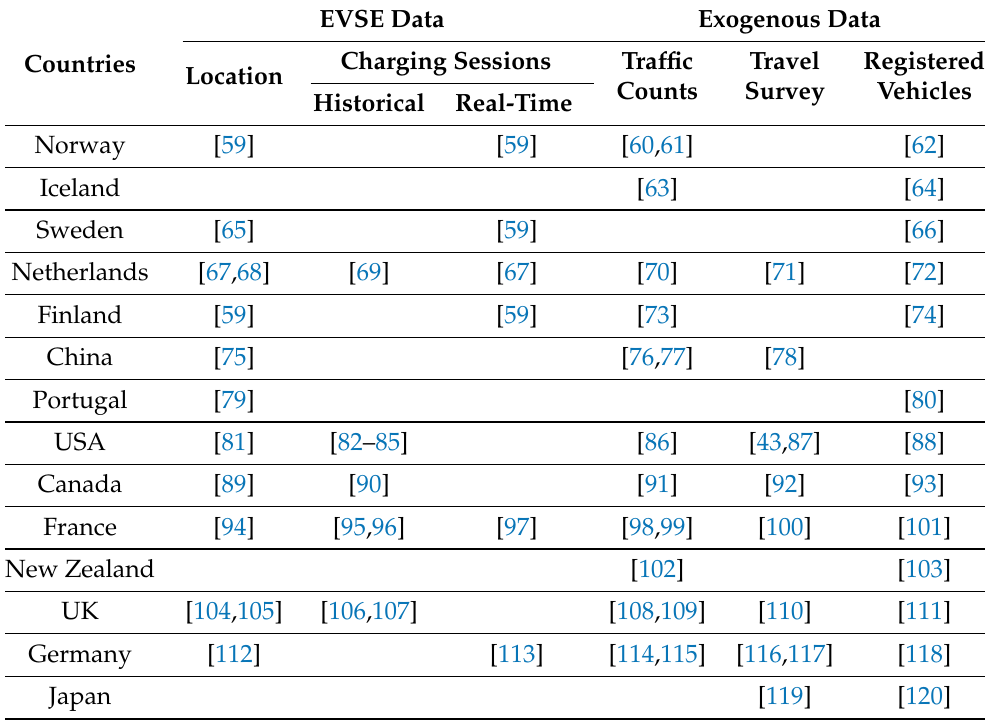
Table 1. The most relevant open dataset available found in this research with the associated references.